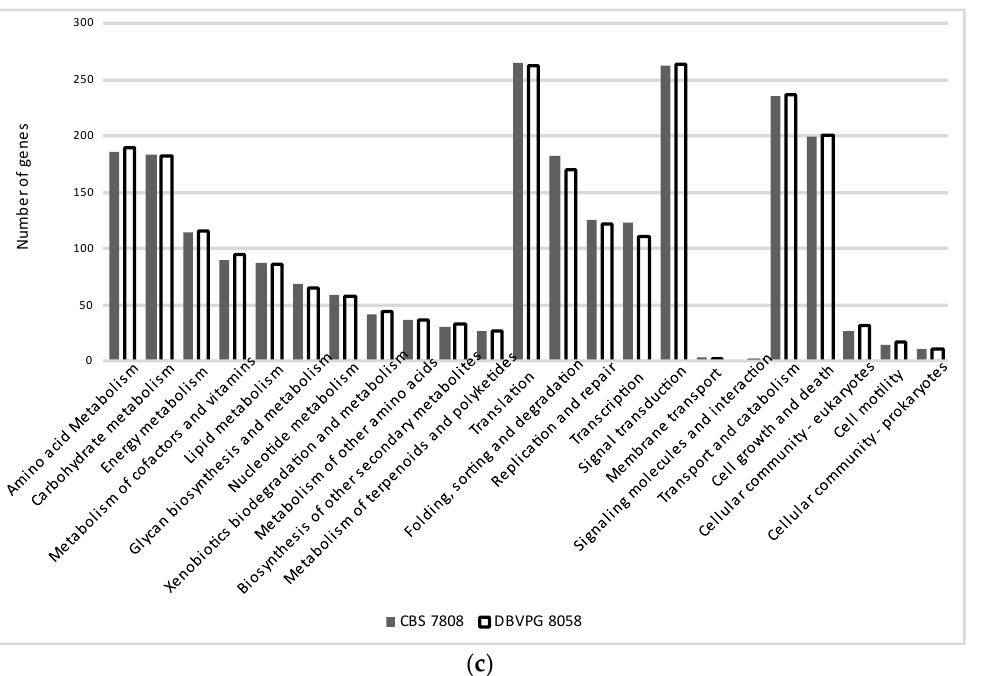
Figure 3. Assigned numbers of genes to the top 10 of the GO categories: biological processes, cellular components, and molecular functions in CBS 7808 ( a ) and DBVPG 8058 ( b ). ( c ) Assigned number of genes to the five KEGG top categories: metabolism, genetic information processing, environmental information processing, cellular processes, and organismal systems. KEGG (Kyoto Encyclopedia of Genes and Genomes), GO (Gene Ontology).